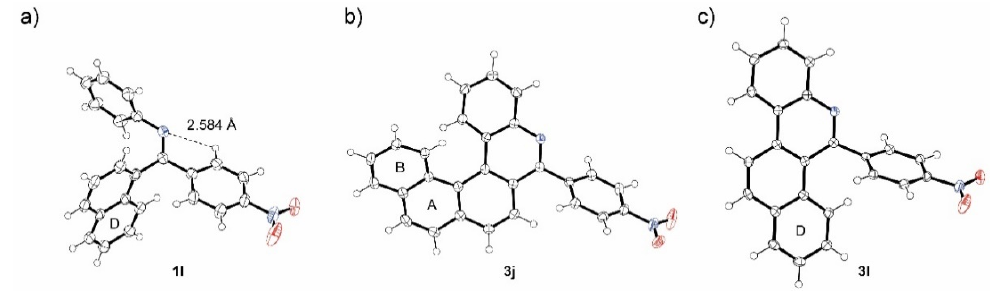
Figure 5. ORTEP projection of the crystal structure of 1l ( a ), 3j ( b ) and 3l ( c ). Thermal ellipsoids are shown with 50% probability.